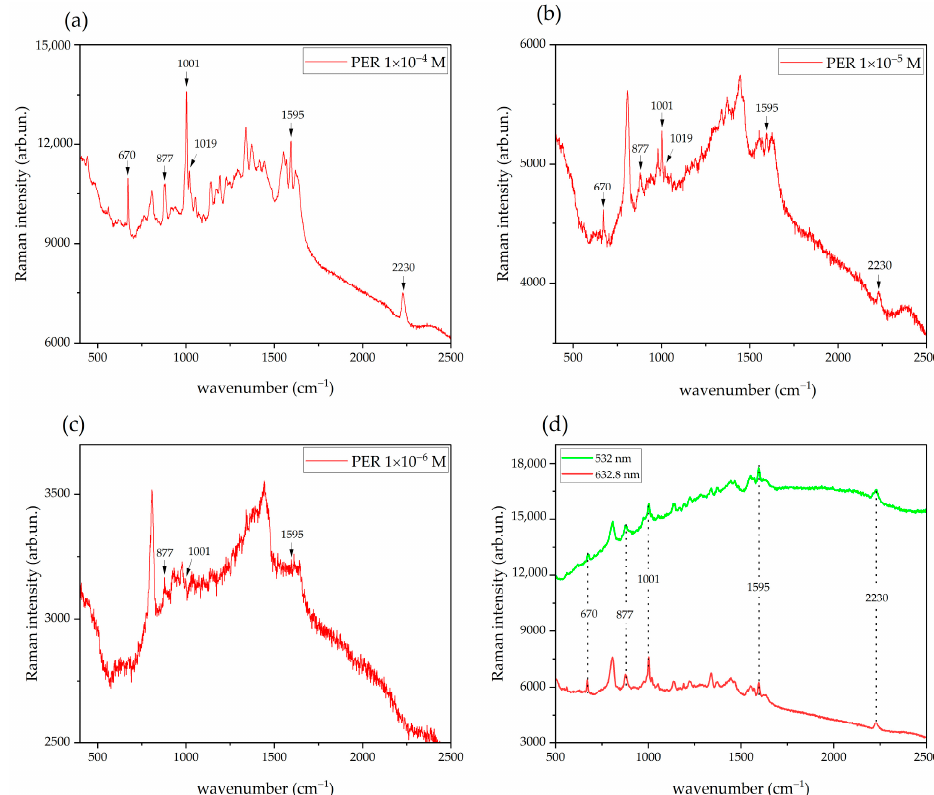
Figure 6. ( a – c ) SERS spectra of acidified PER in the range 1 × 10 − 4 M–1 × 10 − 6 M recorded with 632.8 nm excitation, 20 × objective, 5 mW incident power, 10 s exposure time (5 averages), and spinning cell setup. ( d ) SERS spectra of acidified PER 1 × 10 − 4 M, recorded with 532 nm (3 mW) and 632.8 nm (5 mW) excitation wavelengths, 20 × objective, 10 s exposure time (5 averages), and spinning cell setup. All the spectra are reported with no background subtraction and no normalization.